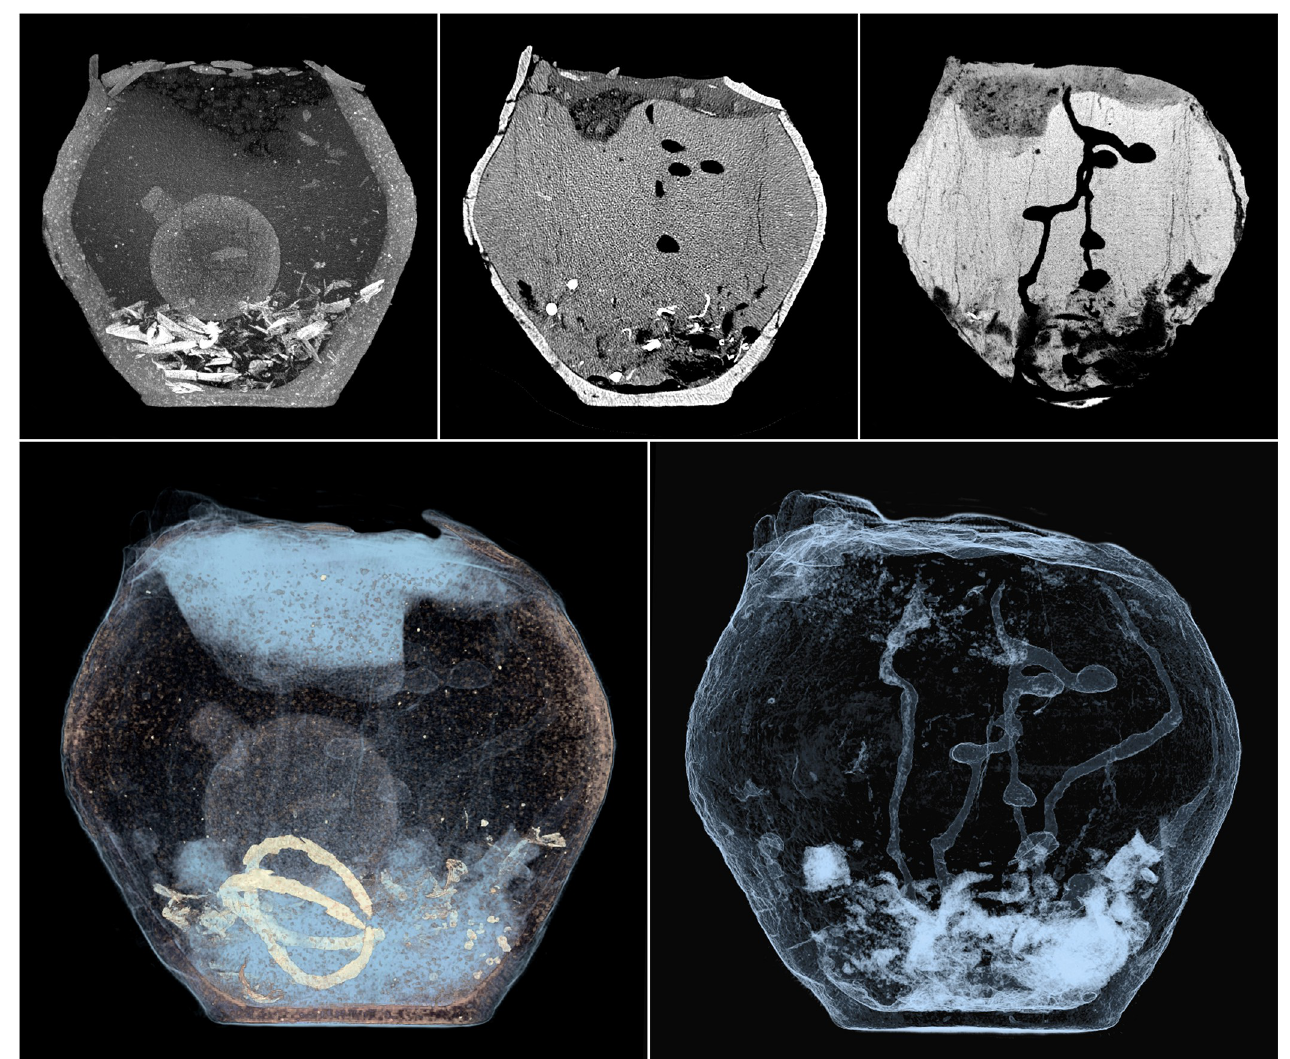
Fig 13. The imaging the urn B from grave 632 in order to accentuate the complexity of the elements of the fill. The MIP reconstruction shows an additional vessel placed over the burnt bones, while in the CT slices individual nest chambers of Geotrupes stercorarius are visible, and in the MinIP reconstruction, a part of the dung beetle nest is visualized (top row). At the bottom—the VR reconstruction, which contains all the components of the fill, including metal ornaments, and the VR reconstruction highlighting the complexity and state of preservation of the G . stercorarius nest filling up the urn.